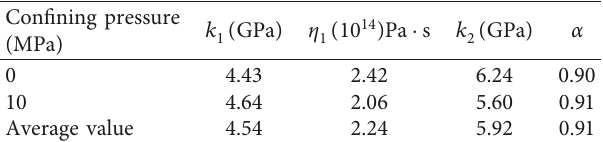
Table 1: Parameters determined by fitting analysis based on creep tests.